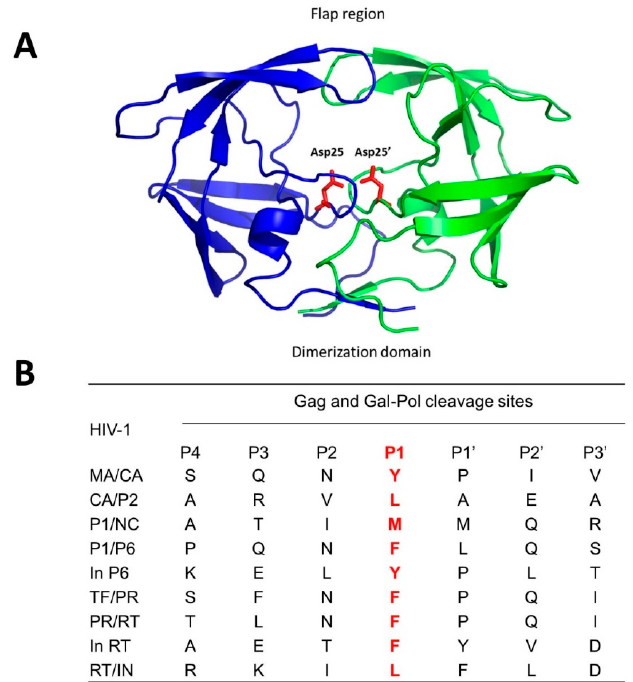
Figure 3. Crystal structure of HIV-1 protease ( A ), and its cleavage sites ( B ). The catalytic site resides between two monomers (blue and green), and Asp25 and Asp25’ (red) from each dimer orchestrate the cleavages (PDB: 2NMZ). The flap region and dimerization domain are also shown. Cleavage sites (amino acids) of mature proteins of HIV-1 are listed. The red color indicates P 1 specificity.